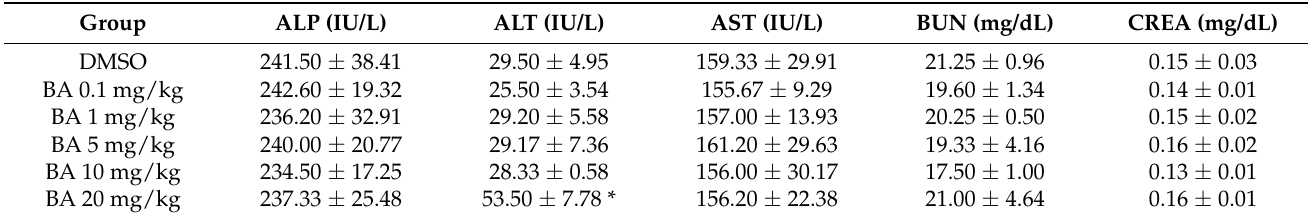
Table 1. Biochemical